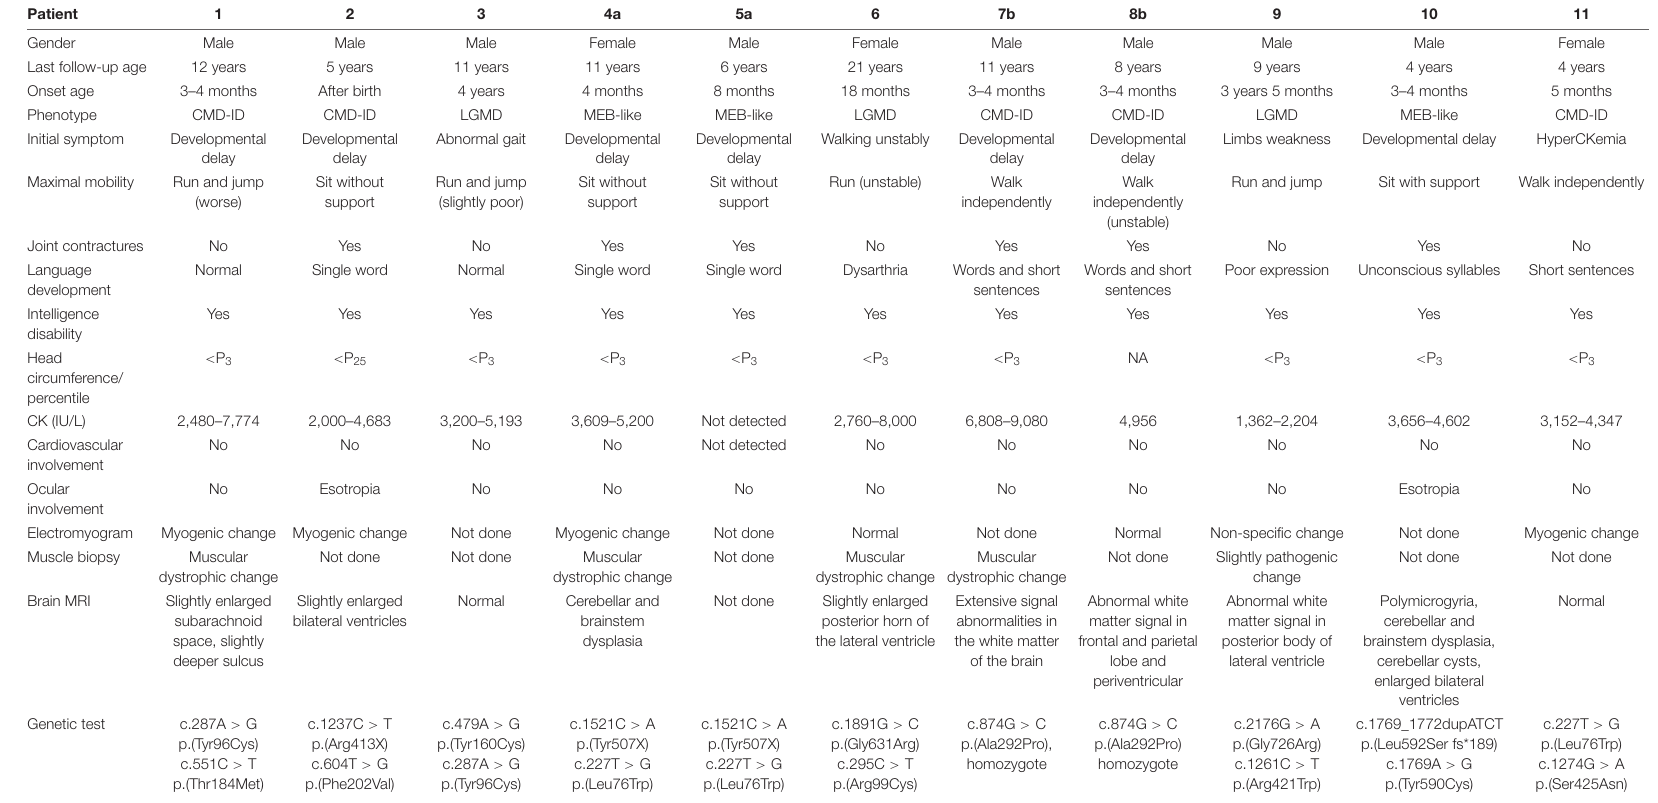
TABLE 1 | Clinical characteristics of 11 POMT2 -related alpha-dystroglycanopathy ( α -DGP) patients. Patient Gender